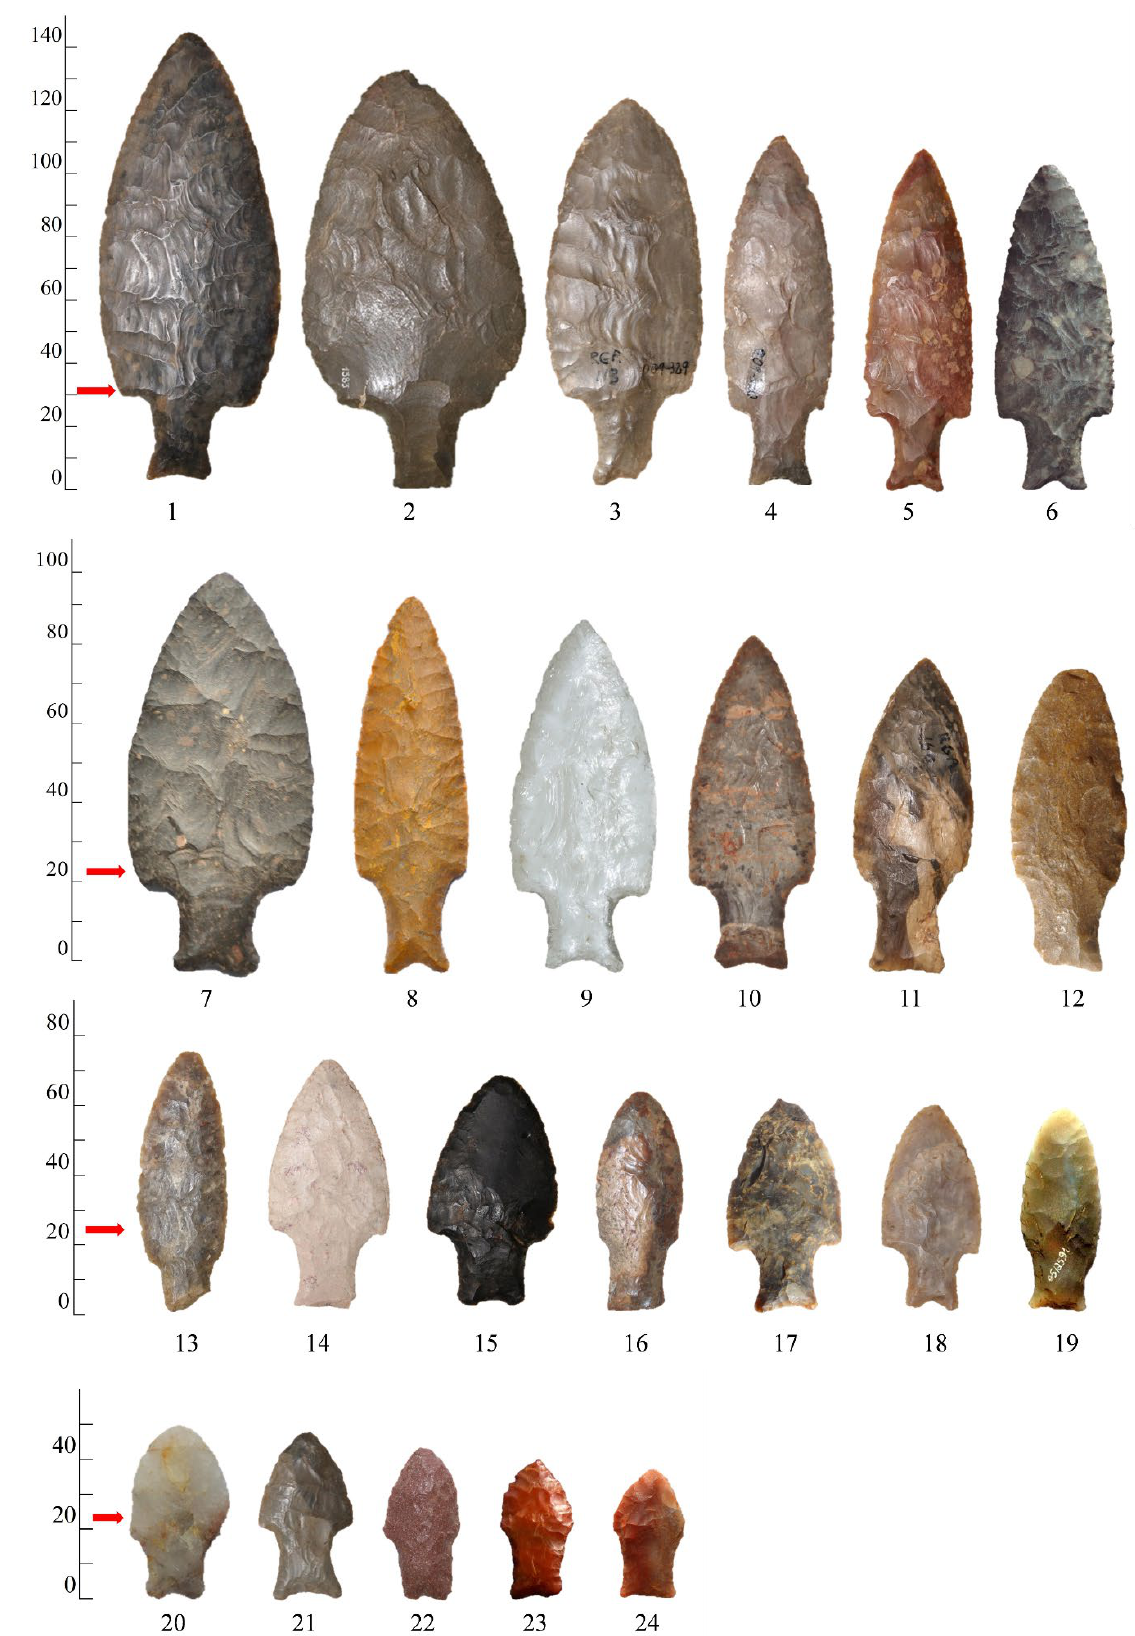
Figure 3. FPs included in this study. The red arrow indicates the average length of the